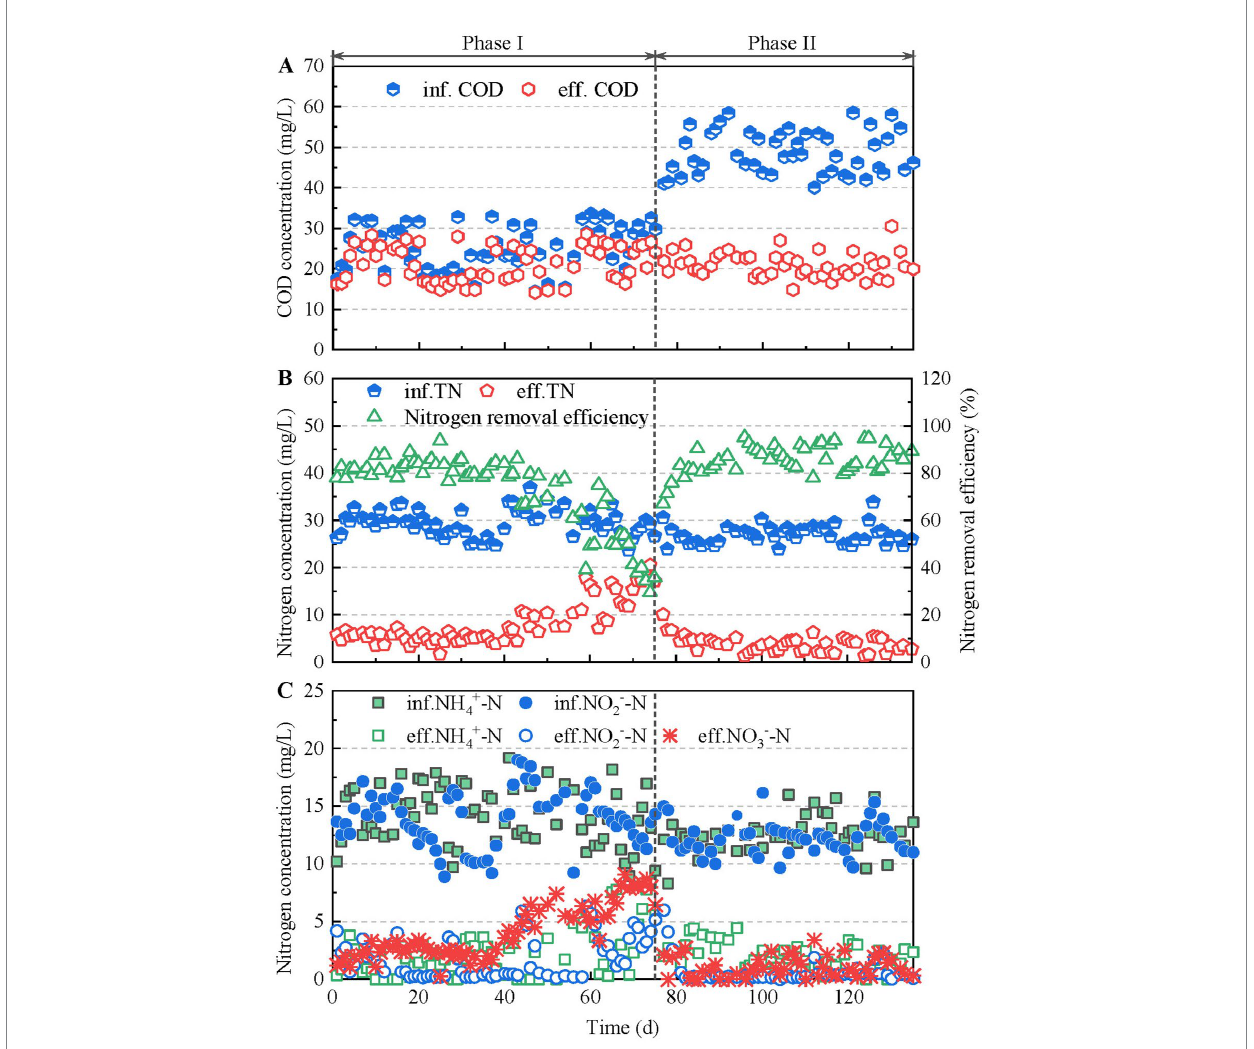
FIGURE 2 The COD (A) and TN (B) removal performance, as well as N-compound concentrations in the influent and effluent (C) of the mainstream anammox